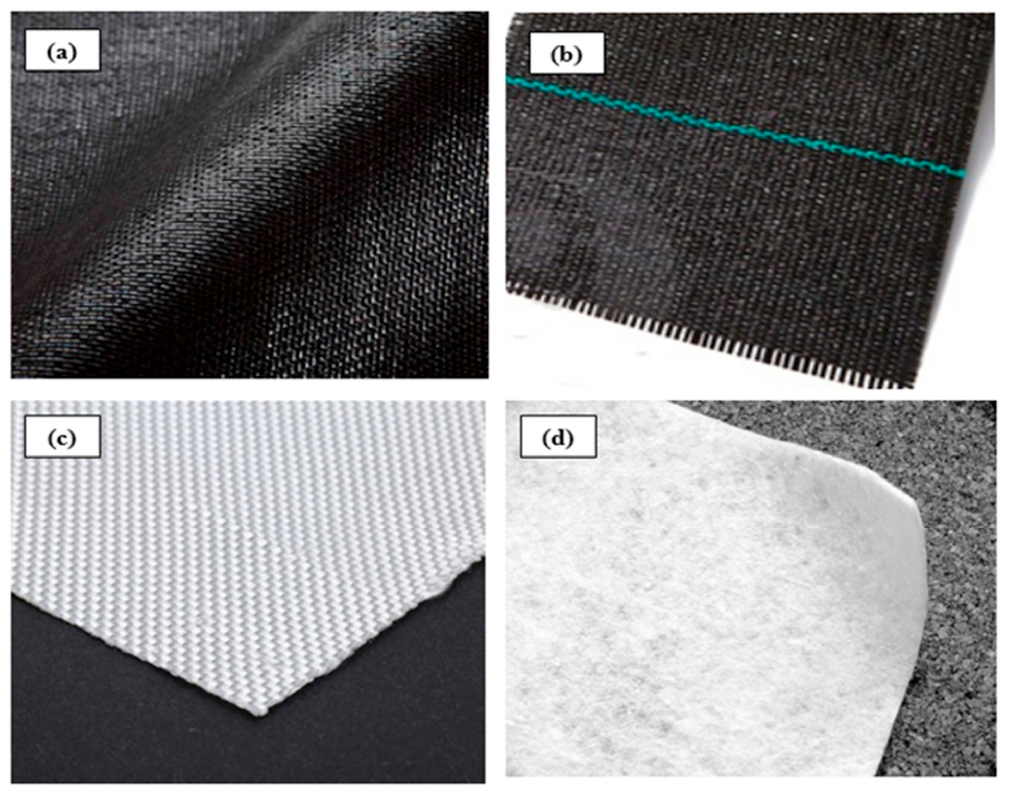
Figure 2. Four different types of geotextiles, three woven; ( a ) GW1, ( b ) GW2, and ( c ) GW3, and one non-woven ( d ) (NW) used in this study. Particle size distribution for different sands used in this study. Table 2 . Properties of geotextiles used in this study.